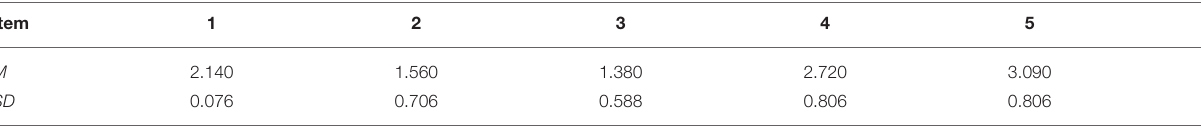
TABLE 6 | Mean social distance score for the six questions.